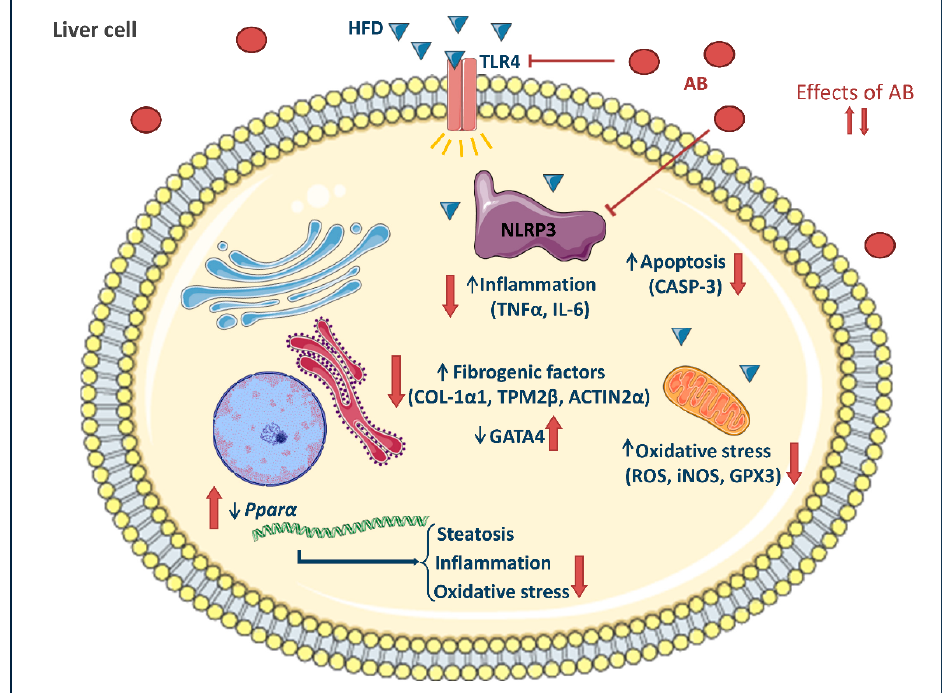
Figure 7. Potential mechanisms of action of AB bioactive compounds on inflammation and oxidative stress processes. The saturated fatty acids of the HFD and/or adipose tissue lipolysis enter the bloodstream and act as ligands of the TLR4 receptor. This binding activates several signaling pathways in liver cells to promote the progression of liver damage. AB extract promotes a decrease in TLR4 activation and oxidative stress production in the cell, which reduces NLRP3 inflam- masome activation and apoptotic markers, increases Ppar α mRNA expression, and decreases the gene expression of fibro- genic molecules, reducing inflammation, oxidative stress, and